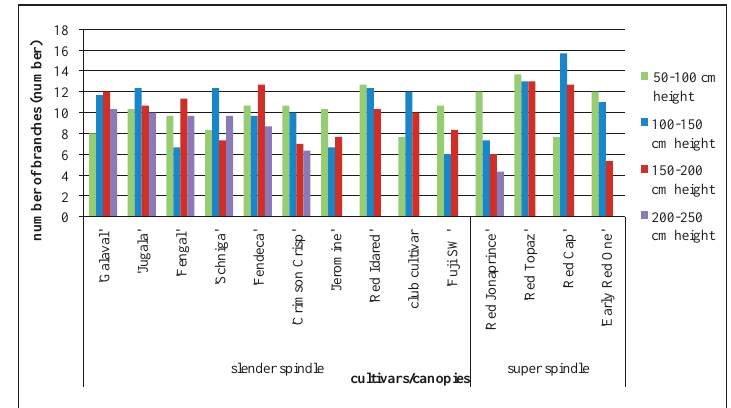
Figure 3: Number of the branches in different height zones of the central leader (Nyírbátor, 2014).